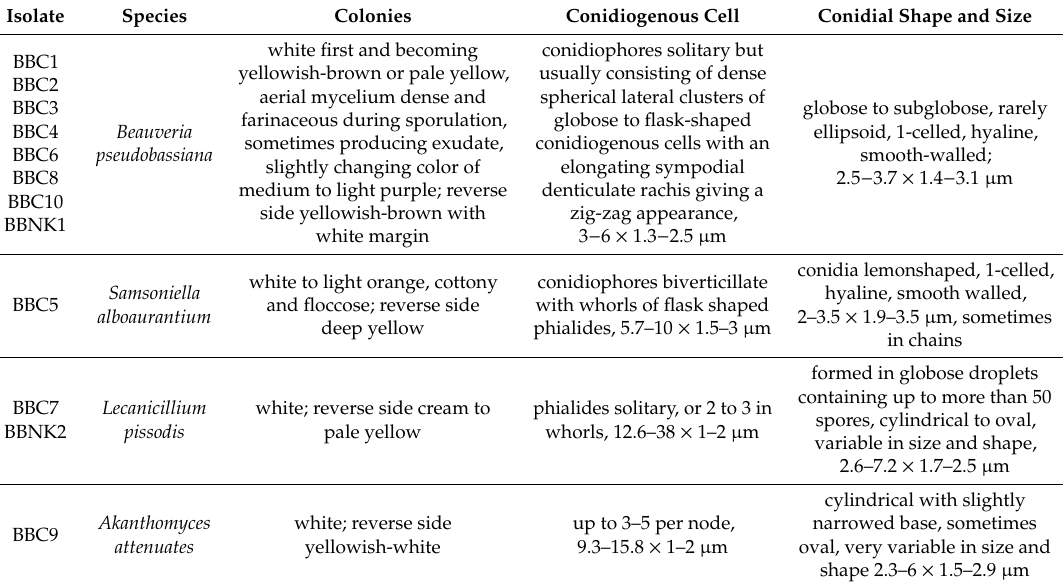
Table 2. Summary of the main morphological characteristics of four recognized fungal species found on Corythucha arcuata